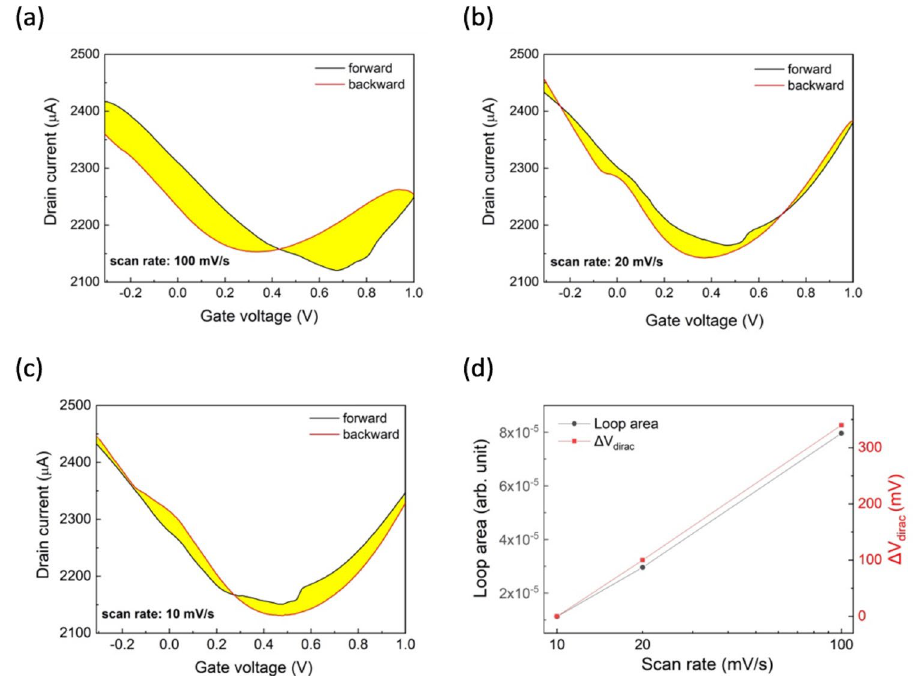
Figure 3. ( a )–( c ) Hysteresis curves of the graphene electrolyte-gated transistor for various scan rates of the sweeping gate voltage (Ag/AgCl PCB reference electrode, 0.1× PBS), ( d ) Loop area enclosed between two transfer curves by sweeping forward and backward the gate voltage and respective V Dirac change as a function of the scan